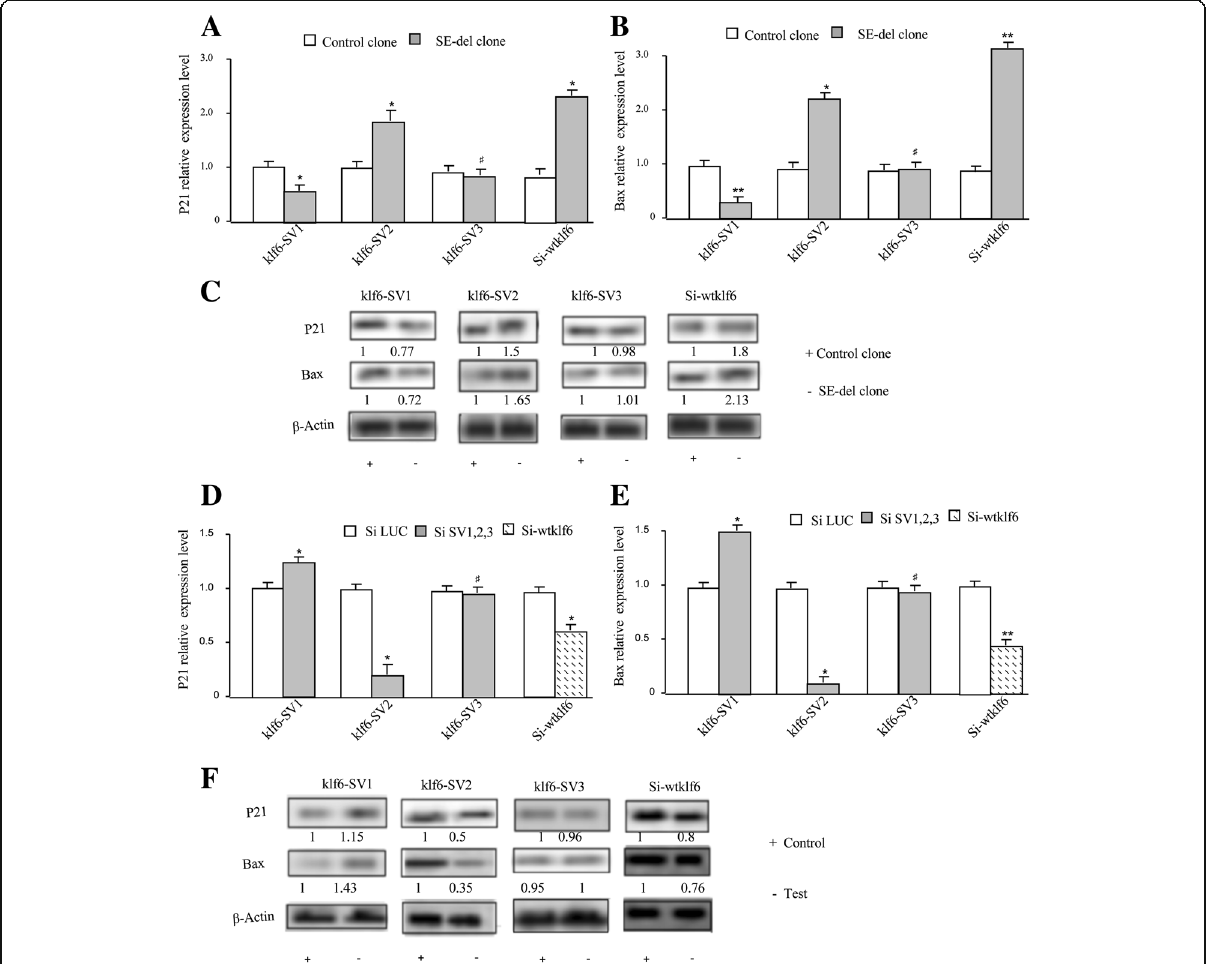
Fig. 5 The effect of Klf6 variants on the expression of P21 and Bax genes. a Expression of p21 mRNA in SE-non-del clone transfected with various siRNA. The results represent the mean of three amplifications, ♯ p > 0.05, * p < 0.05. b Expression of Bax mRNA in SE-non-del clone transfected with various siRNA. The results represent the mean of three amplifications, ** p < 0.01, * p < 0.05, ♯ p > 0.05. c Expression of p21 and Bax proteins in SE- non-del clone transfected with various siRNA. d Expression of p21 mRNA in SE-non-del clone with over-expression of various Klf6 variants. The results represent the mean of three amplifications, ♯ p > 0.05, * p < 0.05. e Expression of Bax mRNA in SE-non-del clone with over-expression of various Klf6 variants. The results represent the mean of three amplifications, ** p < 0.01, * p < 0.05, ♯ p > 0.05. f Expression of p21 and Bax proteins